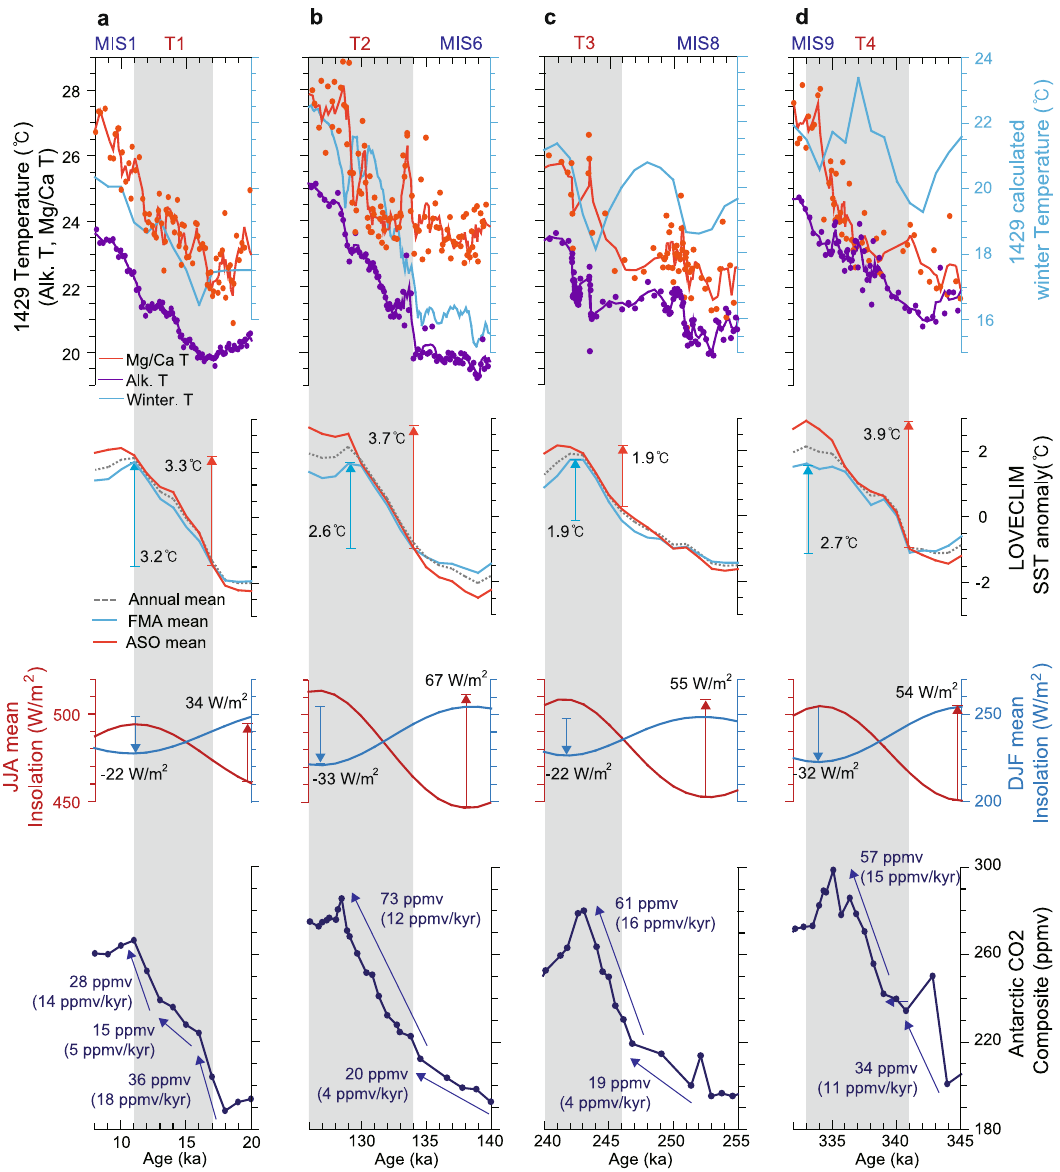
Fig. 7 Reconstructed sea surface temperatures (SST) over the last four glacial terminations. Variations in proxy SSTs at Site U1429, LOVECLIM model SSTs, insolation for June to August and for December to February at the latitude of Site U1429 (31.6°N), and Antarctic composite CO 2 concentration 49 for the period of a 8 − 20 kyr, b 128 − 140 kyr, c 240 − 255 kyr, and d 332 − 345 kyr. Grey shading indicates a glacial termination period 23